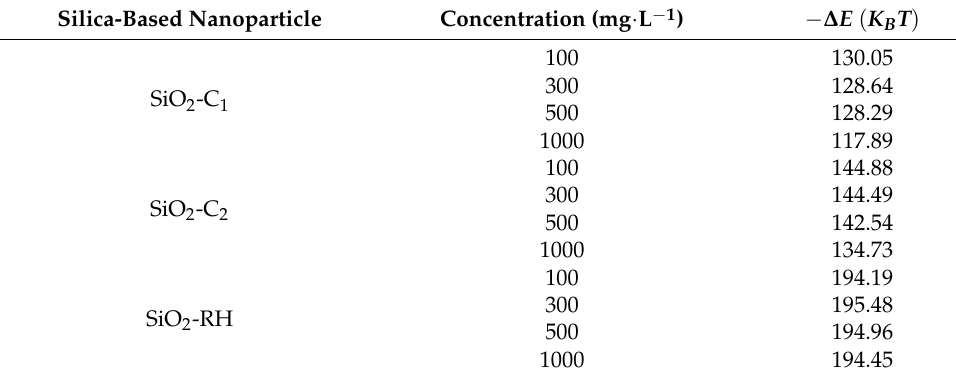
Table 2. Binding energy ( ∆ E ) of a single particle to the oil/water interface for SiO 2 -RH, SiO 2 -C 2 , and SiO 2 -C 1 at different concentrations at 47 ◦